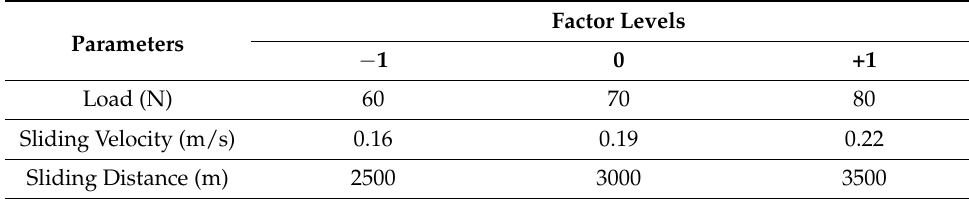
Table 1. Process parameters and their levels.